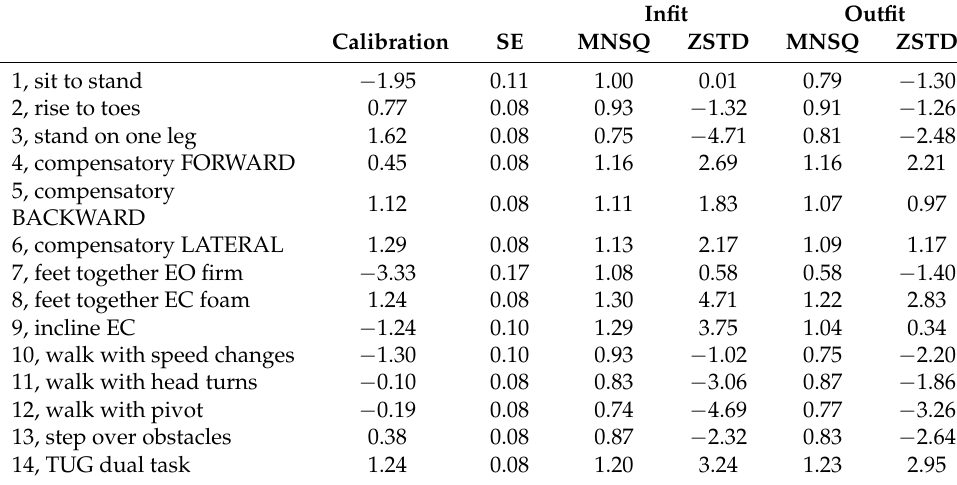
Table 3. Mini-BESTest items calibrations and fit to the Rasch